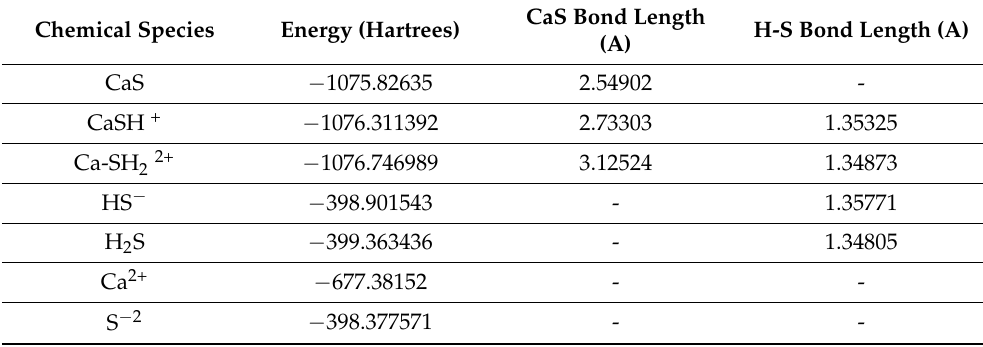
Table 2. Energies associated with various sulfides in solution calculated at the DFT /B3LYP/DGZVP level of